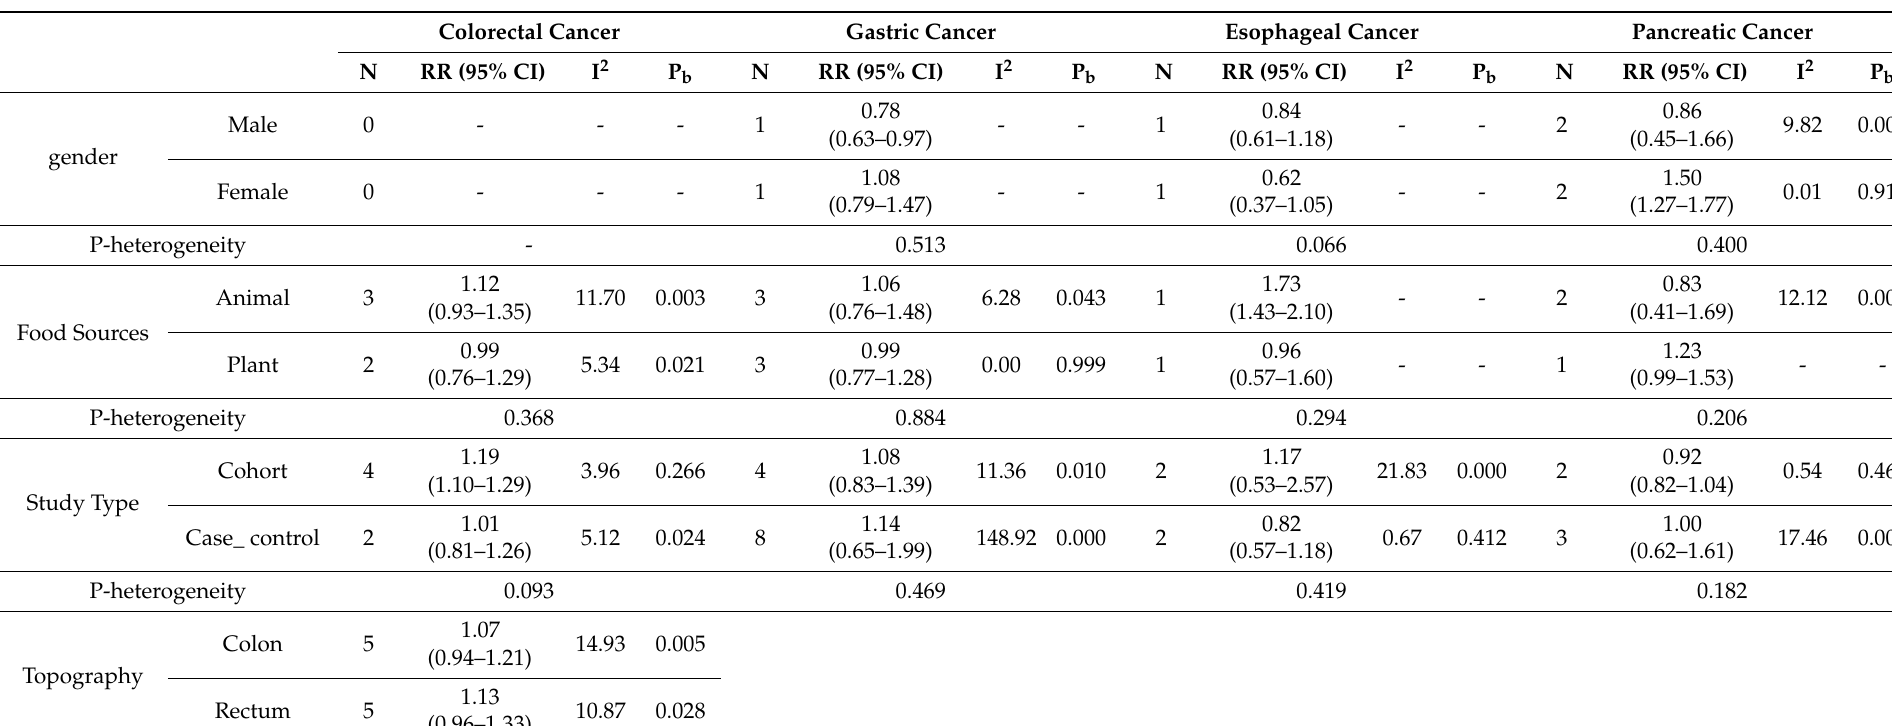
Table 1. Association between nitrate intake and selected gastrointestinal cancers stratified by gender, food sources, study type, and